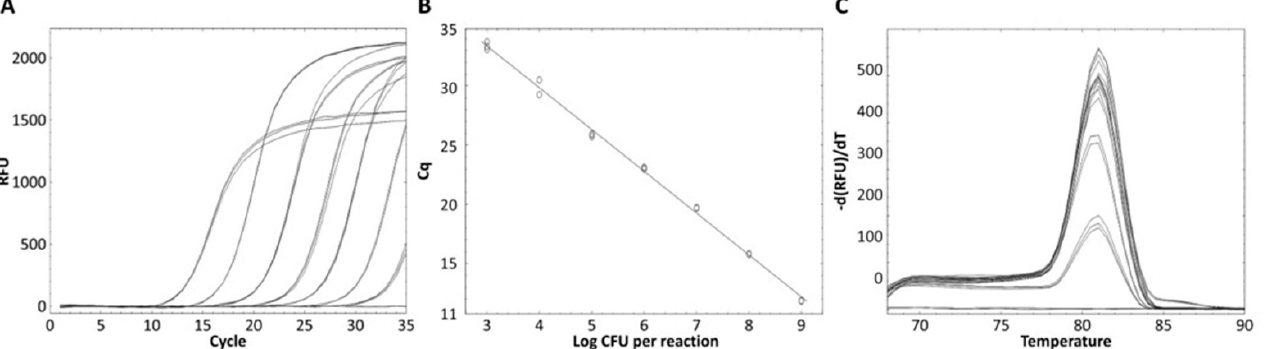
Figure 4. Quantified standard curve of L. zeae . ( A ) Amplification plot and ( B ) melting curve obtained by dilutions of L. zeae from 10 3 to 10 9 CFU/mL. ( C ) Quantified standard curve using the equation y = − 3.530x + 36.906 ( R 2 = 0.997).